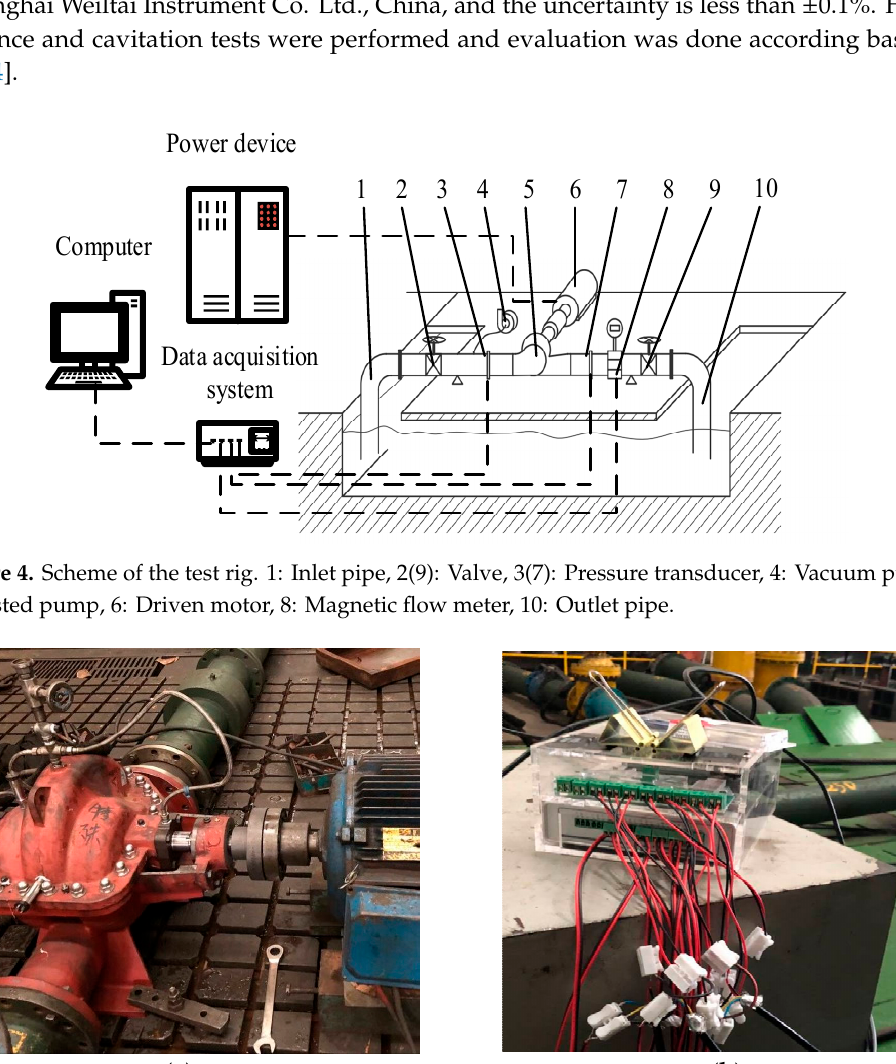
Figure 6. Flowchart of Optimization process. 3.1. Objective Functions In the design process of centrifugal pump, the optimization goals and targets are considered as significant indexes for performance evaluation. For this study, the efficiency and NPSHr of the